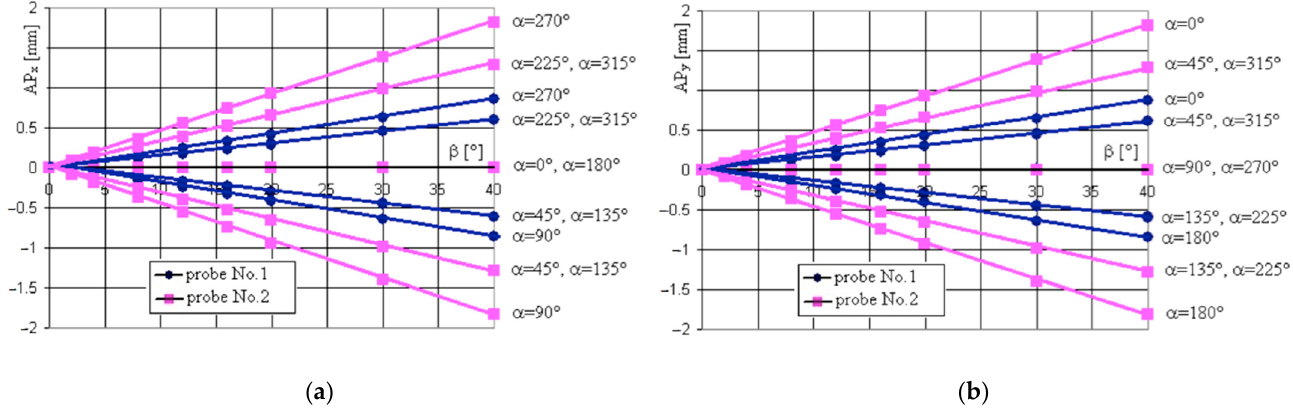
Figure 9. Values of the positioning accuracy AP components at different angles β for Probe 1 and Probe 2, Sample 1: ( a ) AP x = f ( β ); ( b ) AP y = f ( β ).